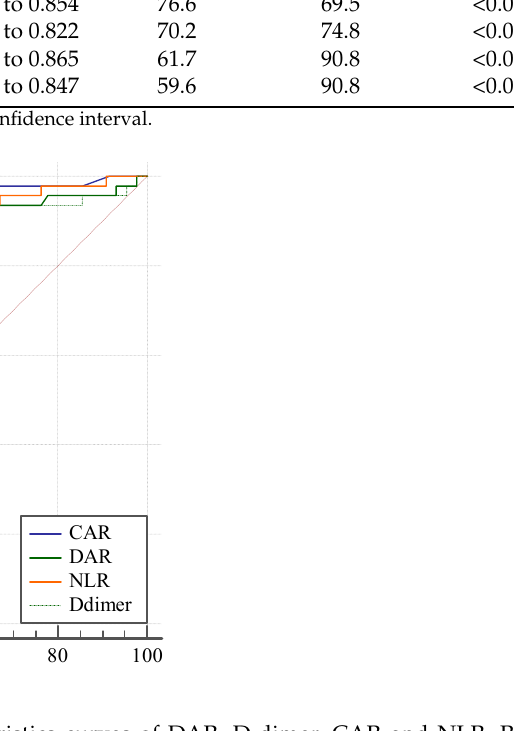
Figure 2. Receiver operating characteristics curves of DAR, D-dimer, CAR and NLR. Receiver operating character (ROC) curves of DAR, D-dimer, CAR, and NLR for predicting 3-month clinical outcomes in aneurysm subarachnoid hemorrhage (aSAH) patients. The area under the curve was 0.81 for DAR, 0.797 for CAR, 0.79 for D-dimer, and 0.764 for NLR. Table 2. Receiver Operating Characteristic Curves for Predicting 3-month Post subarachnoid Hemorrhage Outcome.